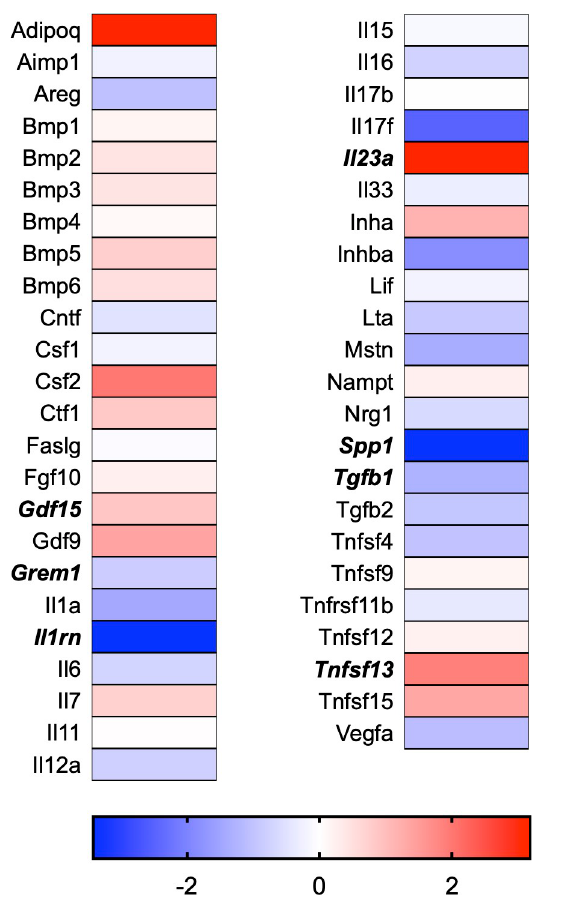
Fig 14. Cytokines heat map. Bold text indicates significantly altered gene